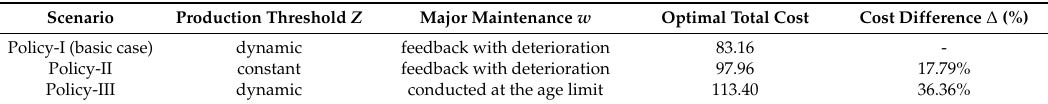
Table 3. Cost difference of the comparative